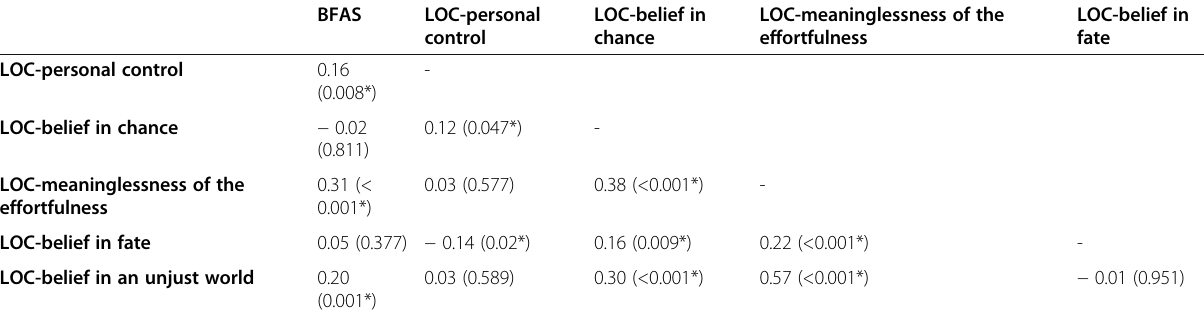
Table 3 Correlations between the BFAS and LOC subscale scores in the students with problematic Facebook